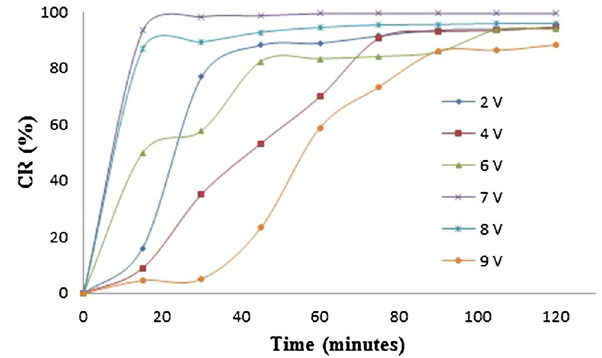
Fig. 4 Effect of applied potential on the removal efficiency of Eriochrome Black 0.20 g L −1 . [NaCl] = 1.0 g L −1 ; electrolysis time = 120 min; and pH